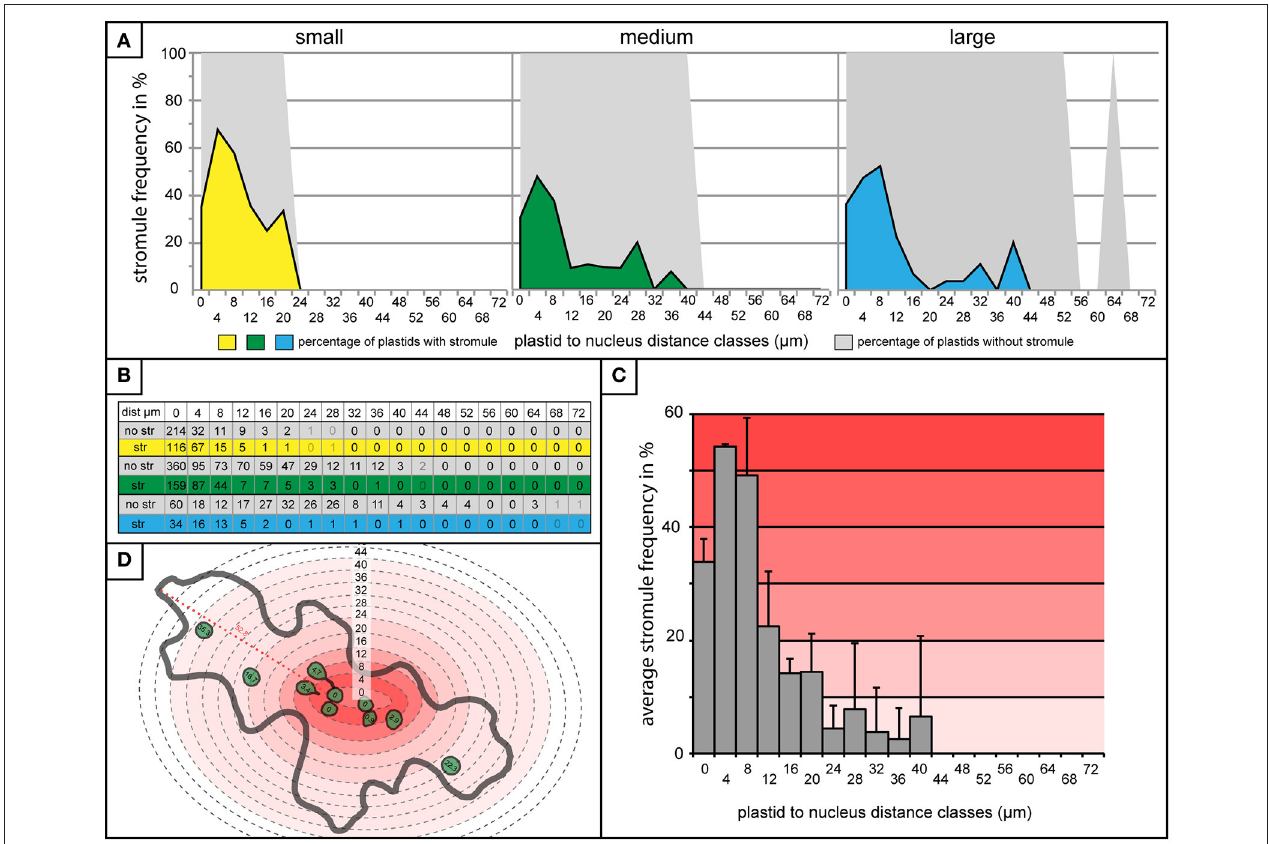
FIGURE 5 | “Stromule-promoting zone” evident within 8 µ m of the nucleus. (A) Histograms showing stromule frequency in each 4 µ m zone at increasing distances from the nucleus (x-axis) in small (yellow), medium (green), and large (blue) cells. Gray areas represent the frequency of plastids without stromules. (B) The plastid sample sizes for each 4 µ m zone which was illustrated in the histograms in (A) . (C) Histogram of stromule frequency in each 4 µ m zone when data sets from all cell sizes are combined. Highest to lowest stromule frequencies are indicated with a dark-light red gradient background. Error bars represent standard deviation. (D) An illustrated example of a cell highlighted according to the stromule frequency gradient outlined in (C) . Defined distance classes from histogram in (C) superimposed onto illustration (this particular cell has plastids in zones up to 40 µ m from the